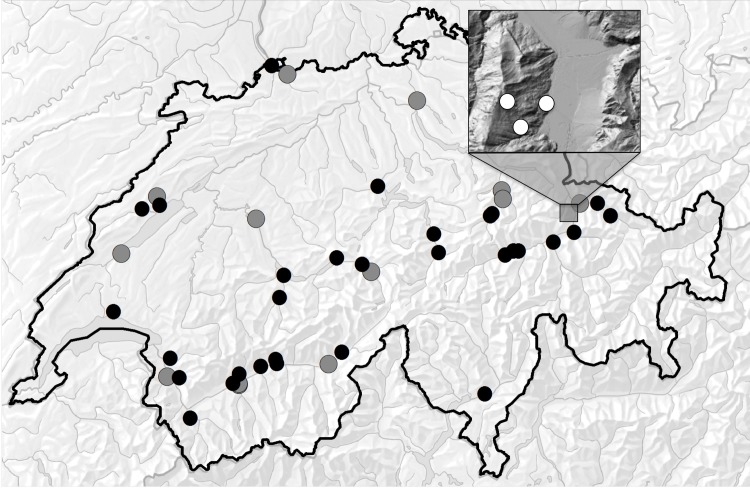
Map of sampled populations and common garden locations.Grey dots—populations included in population genetic analyses and common gardens. Black dots—populations included in population genetic analyses only. White dots in square inset—Common gardens.